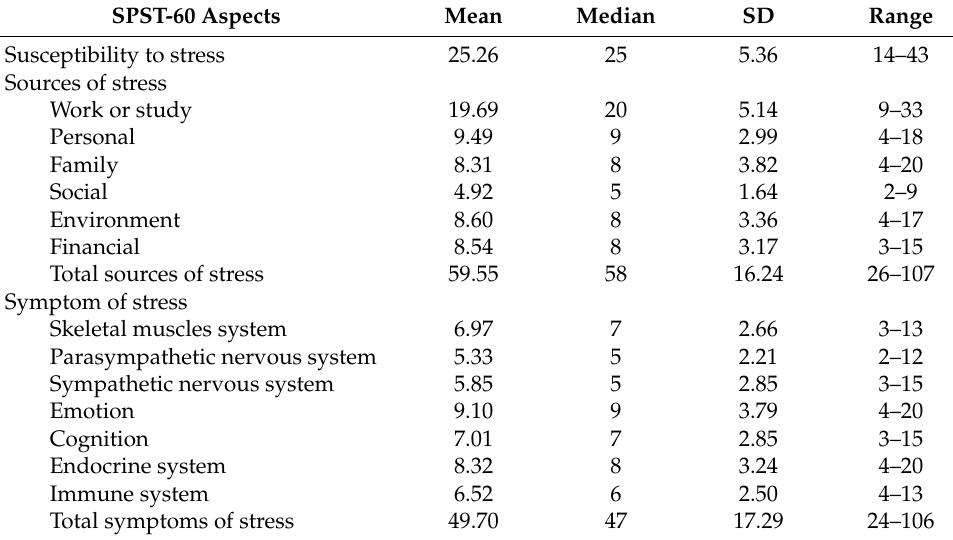
Table 2. Suan Prung Stress Test-60 (SPST-60) scores of female college students ( n = 101).